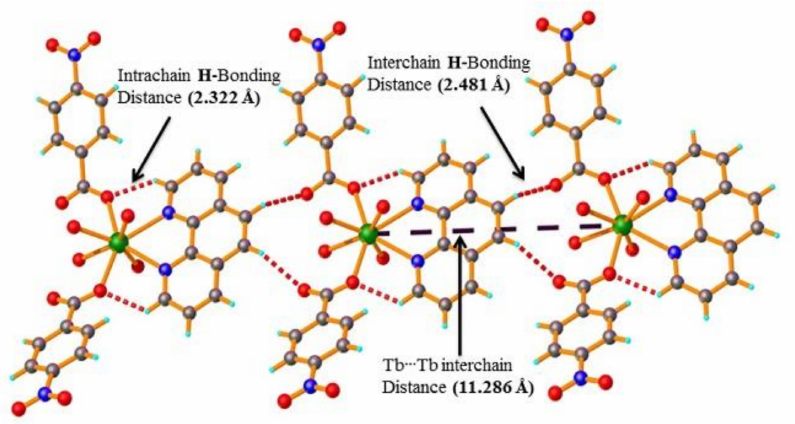
Figure 2. Intrachain and interchain C − H · · · O interaction, with interchain Tb ... Tb distance of 11.286